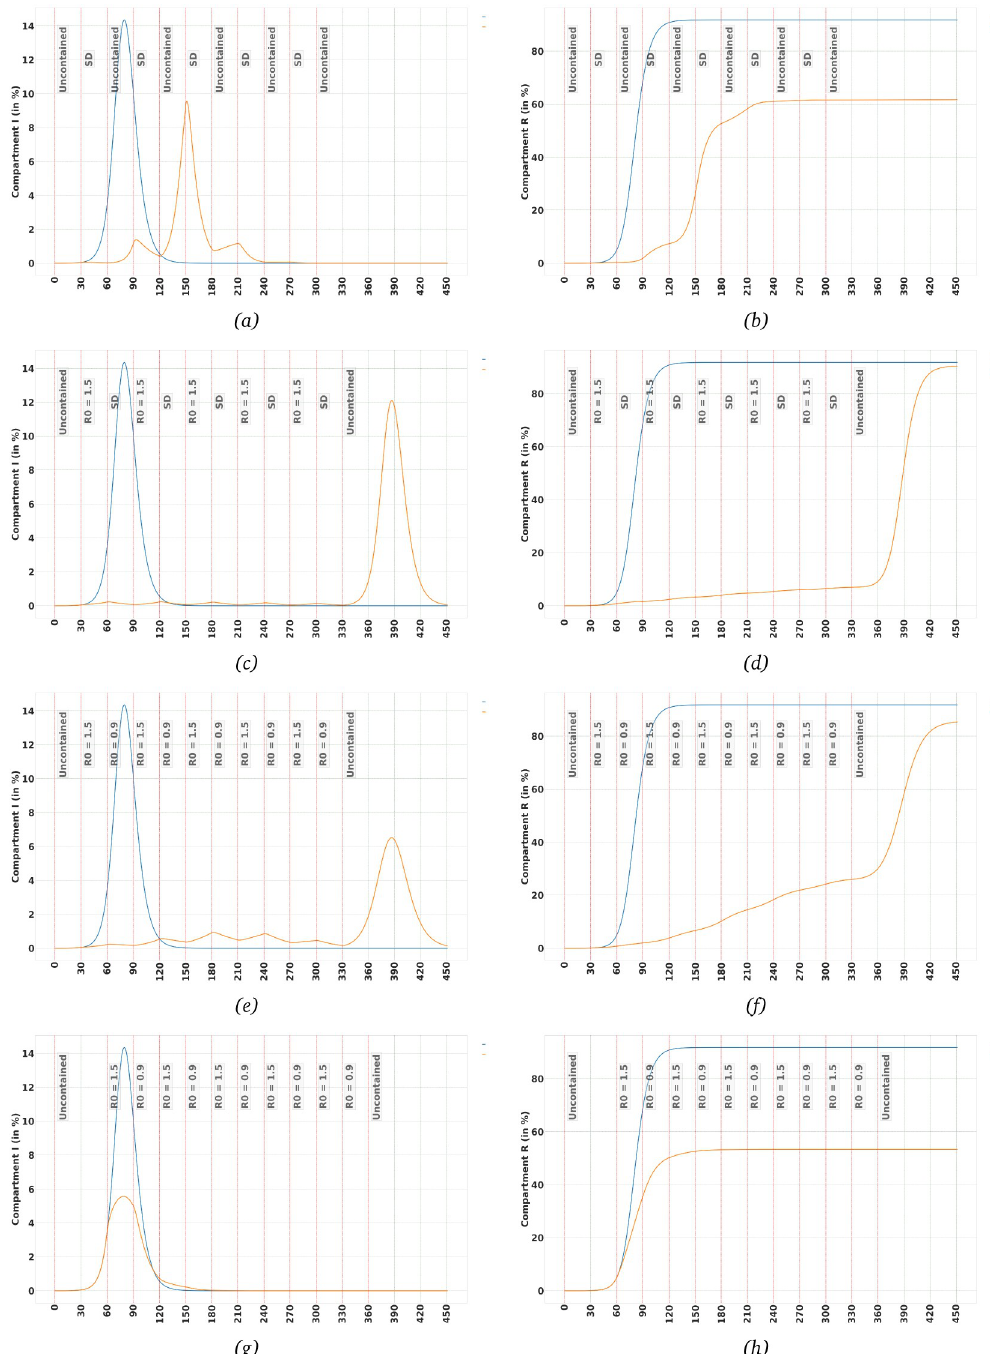
Fig 3. The effects of long-term strategies on Infectious and Recovered trajectories when we switch between policies of different degrees of severity. Polices as defined in Table 2. Lines in blue colour represent the uncontained population. (a,b) Switching between uncontained and social-distancing, SD, scenarios, (c,d) A stricter long-term strategy when we switch between social distancing and R 0 = 1.5 scenarios, (e,f) switching between situations where R 0 = 0.9 and R 0 = 1.5. The policy can contain the spread of the virus when imposed 30 days after 1 in 100,000 in population is Infectious, (g,h) Same as (e) and (f), the only difference is that policy is imposed 60 days after Infectious population reaches 1 in 100,000. An extra 30 days of inaction causes the ratio of Infectious to reach a peak of